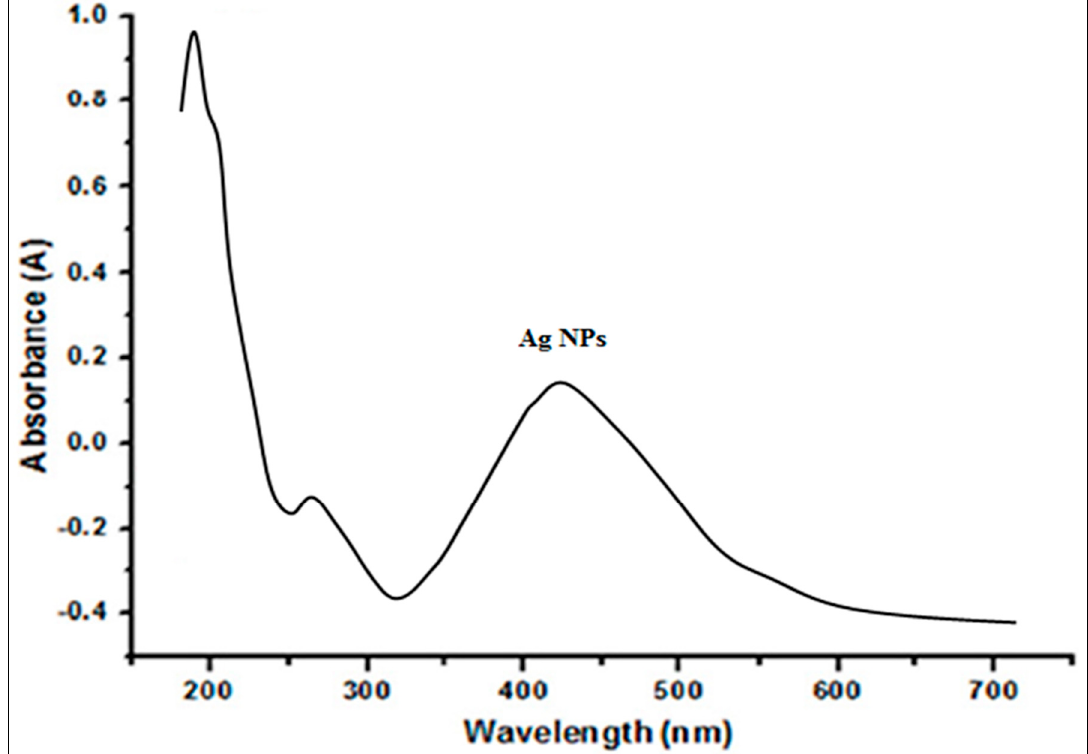
Figure 5. UV–vis spectrum showing formation of silver nanoparticles.